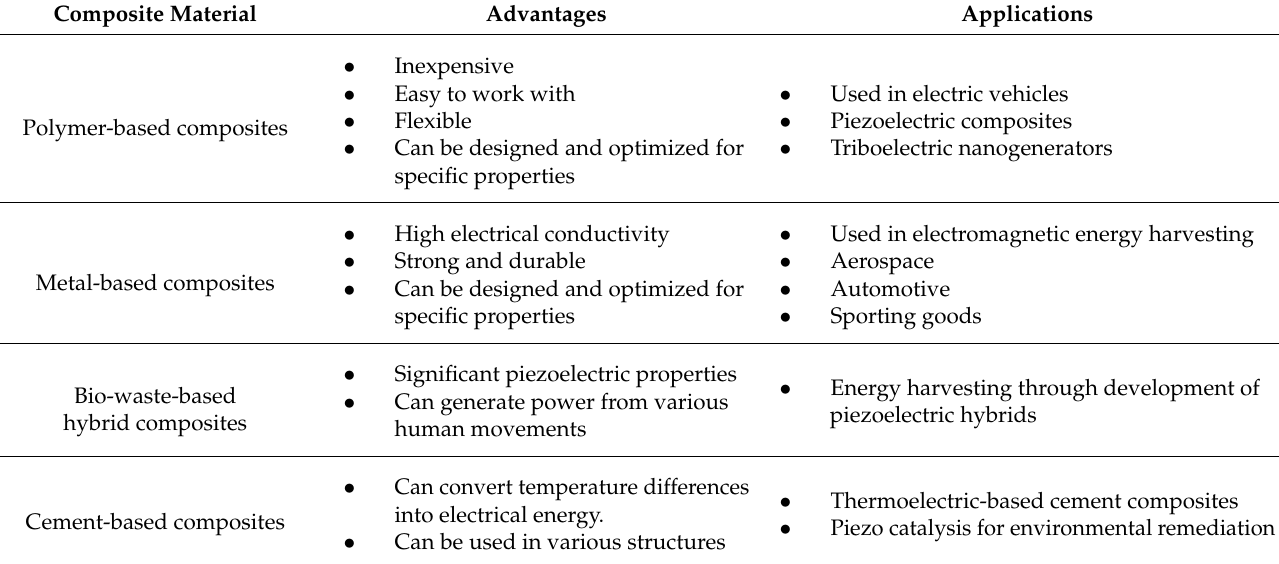
Table 1. Comparison of Composite Materials for Energy